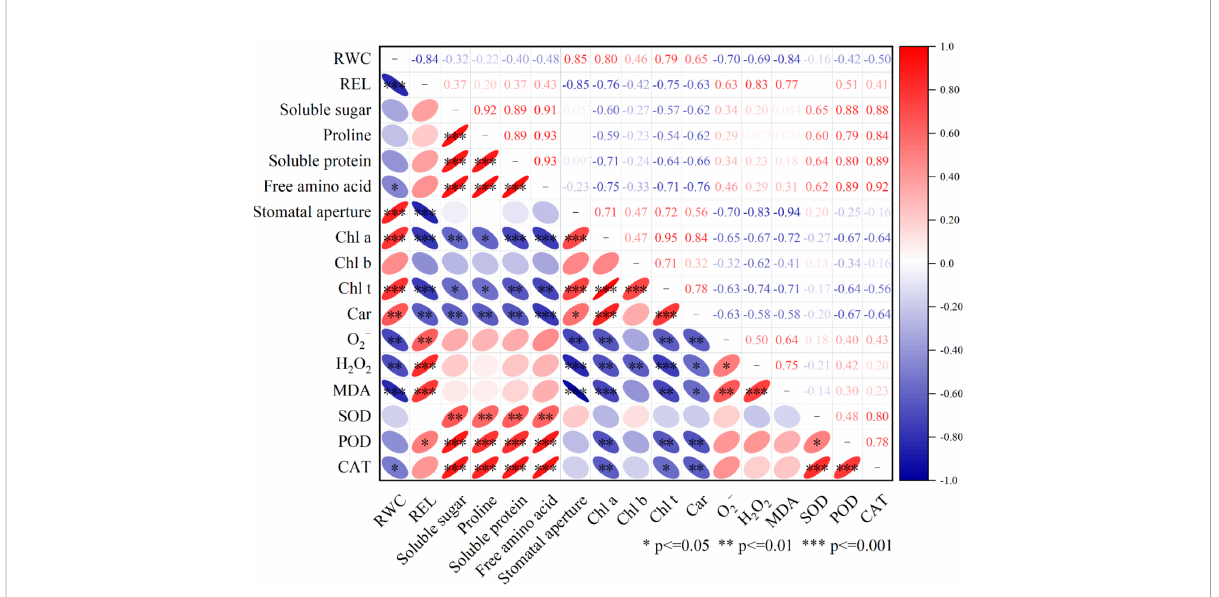
FIGURE 10 Pearson correlation analysis was done on RWC, REL, Soluble sugar, Proline, Suloble protein, Free amino acid, Stomatal aperture, Chl a, Chl b, Chl t, Car, O 2- , H 2 O 2 MDA, SOD, POD, CAT after LA-OH and LA treatments under drought stress. *** — indicates 0.1% signi fi cant (p ≤ 0.001), ** — indicates 1% signi fi cant (p ≤ 0.01), and * — indicates 5% signi fi cant (p ≤